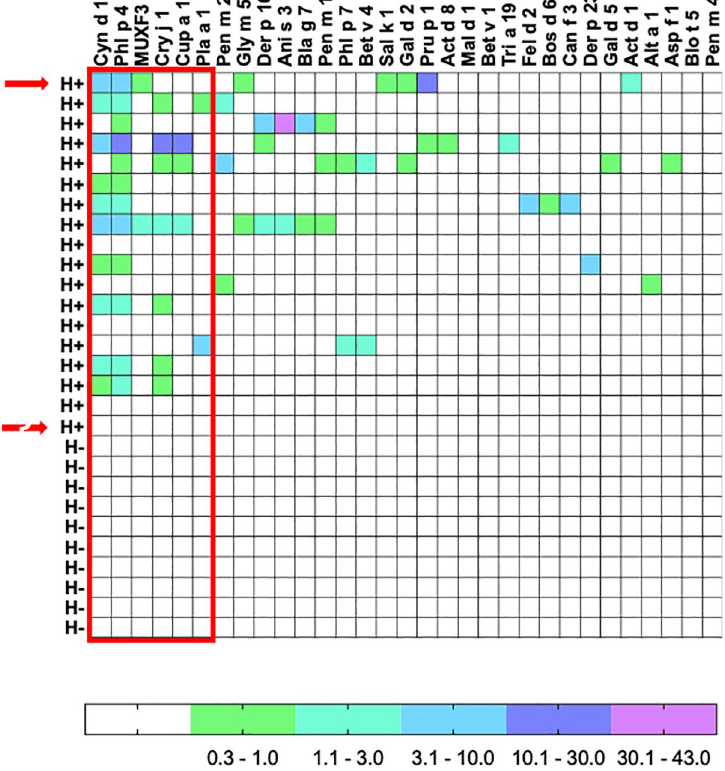
Fig 2. Specific IgE repertoire determined by ISAC. Specific IgE for components measured by the ISAC microarray. Subjects with (H+) and without (H-) helminth infection and allergens with at least one positivity above 0.3 ISU are depicted. Positive results are expressed in ISAC standardized units (ISU) and categorized according to arbitrary ranges. The red framework shows the glycosylated allergens. Red arrows indicate both subjects that developed positive SPT 12 months after